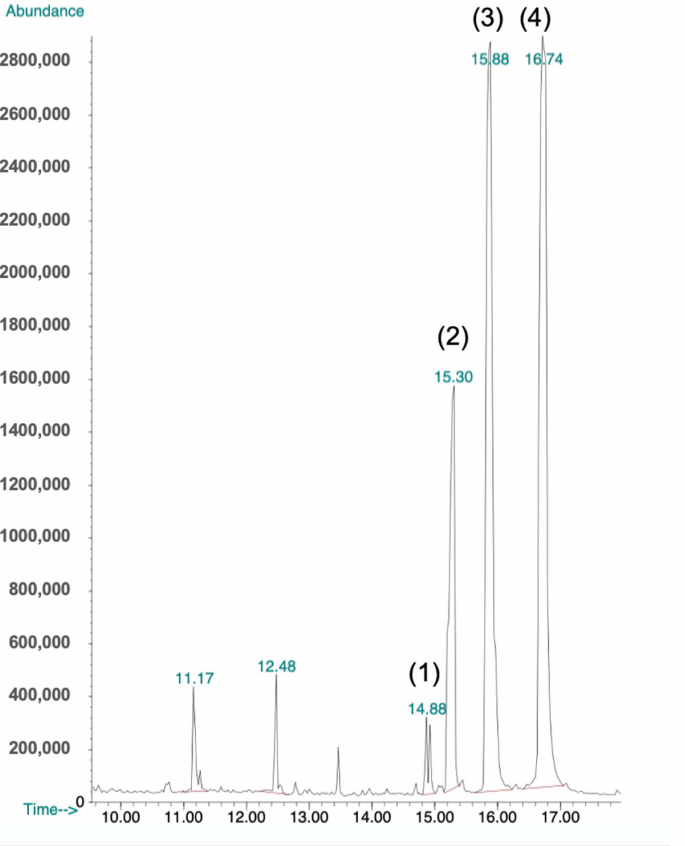
Figure 5. GC-MS chromatogram of bioactive fraction separated in a reverse phase HPLC. Peaks 1, 2, 3, and 4 were evaluated for chemical composition.